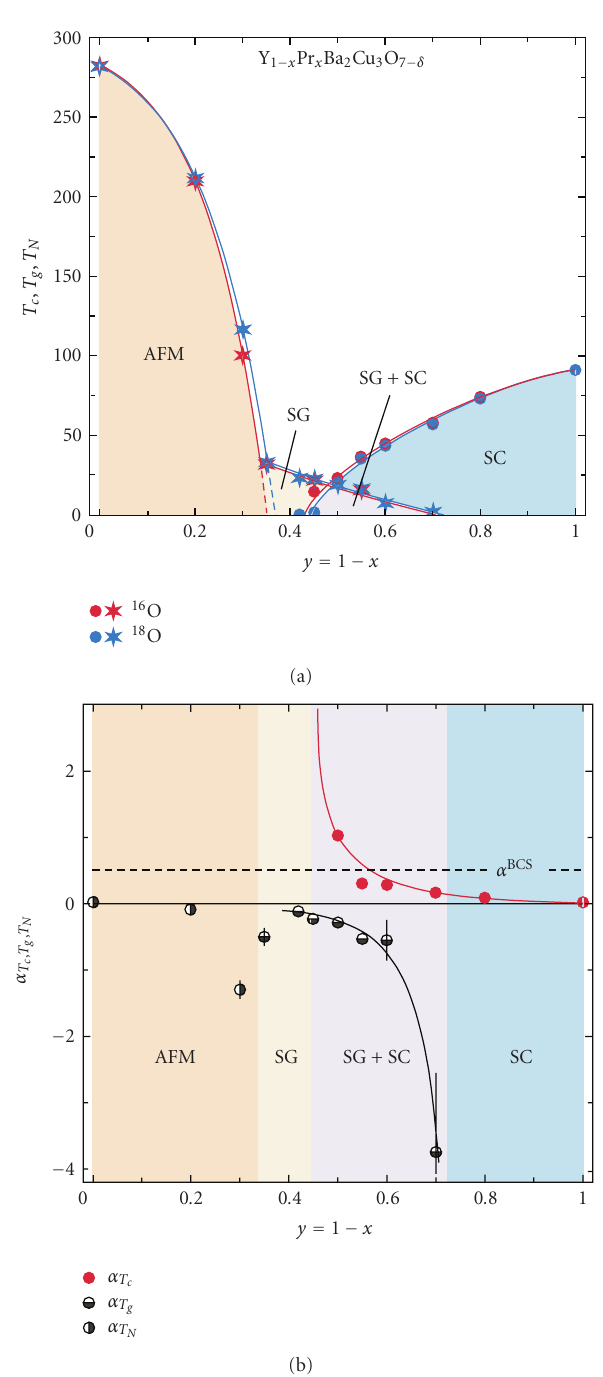
Figure 7: (a) Dependence of the superconducting transition ( T c ), the spin-glass ordering ( T g ), and the antiferromagnetic ordering ( T N ) temperatures for 16 O / 18 O-substituted Y 1 − x Pr x Ba 2 Cu 3 O 7 − δ on the Pr content y = 1 − x . The solid lines are guides to the eye. The areas-denoted by “AFM”, “SG”, and “SC” represent the antiferromagnetic, the spin-glass, and the superconducting regions, respectively, and “SG + SC” corresponds to the region where spin-glass magnetism coexists with superconductivity. (b) OIE exponents α O of T c , T g , and T N for 16 O / 18 O-substituted Y 1 − x Pr x Ba 2 Cu 3 O 7 as a function of the Pr content y = 1 − x . The = 0 . 5. The solid lines dashed line corresponds to the BCS value α BCS O are guides to the eye, after